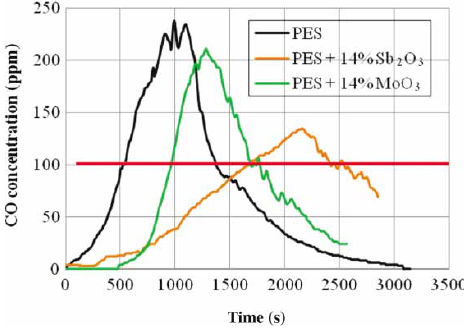
Fig. 12. CO concentration time series registered by B1 sensor located at the centre of the compartment (post B) at 1.6 m for three studied